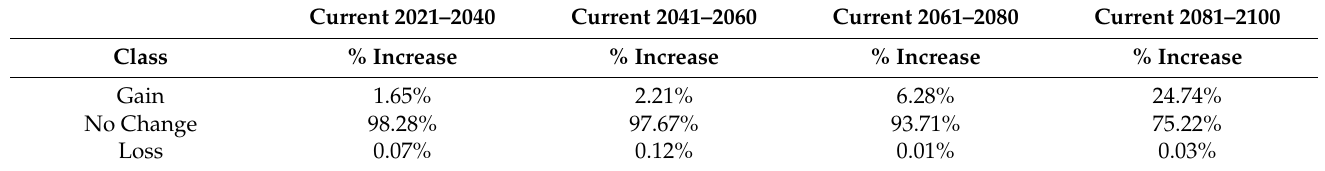
Table 4. Percentage of distributional changes of 16SrII-B between current and future climate-change scenarios.